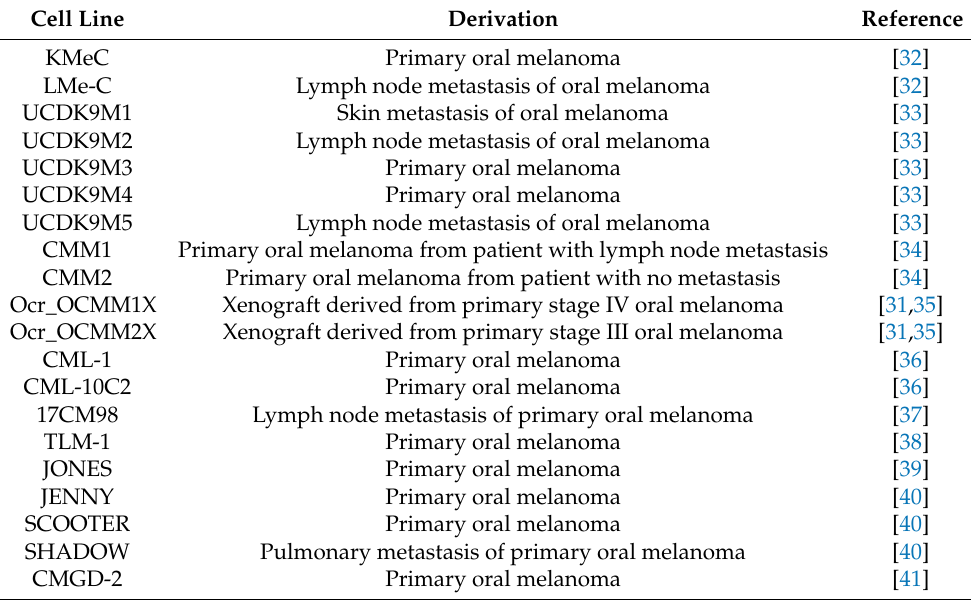
Table 1. Established canine oral melanoma cell